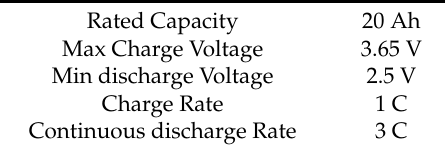
Figure 4. Battery testing bench. Table 2. Specification of LiFePO 4 Power